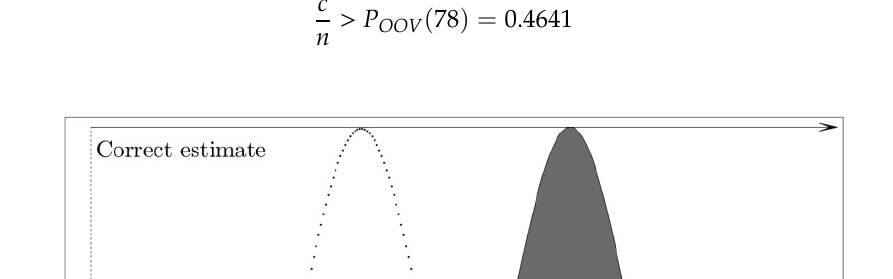
follows the distribution 𝒩 (cid:4678)𝑃 (cid:3032)(cid:3051)(cid:3043) (77), n (cid:3041)